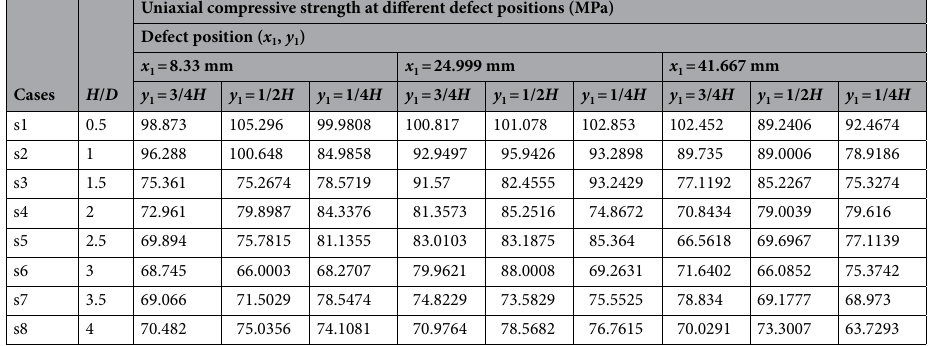
sample. And the growth curve of strain energy peak of intact rock sample and defective rock sample is similar.